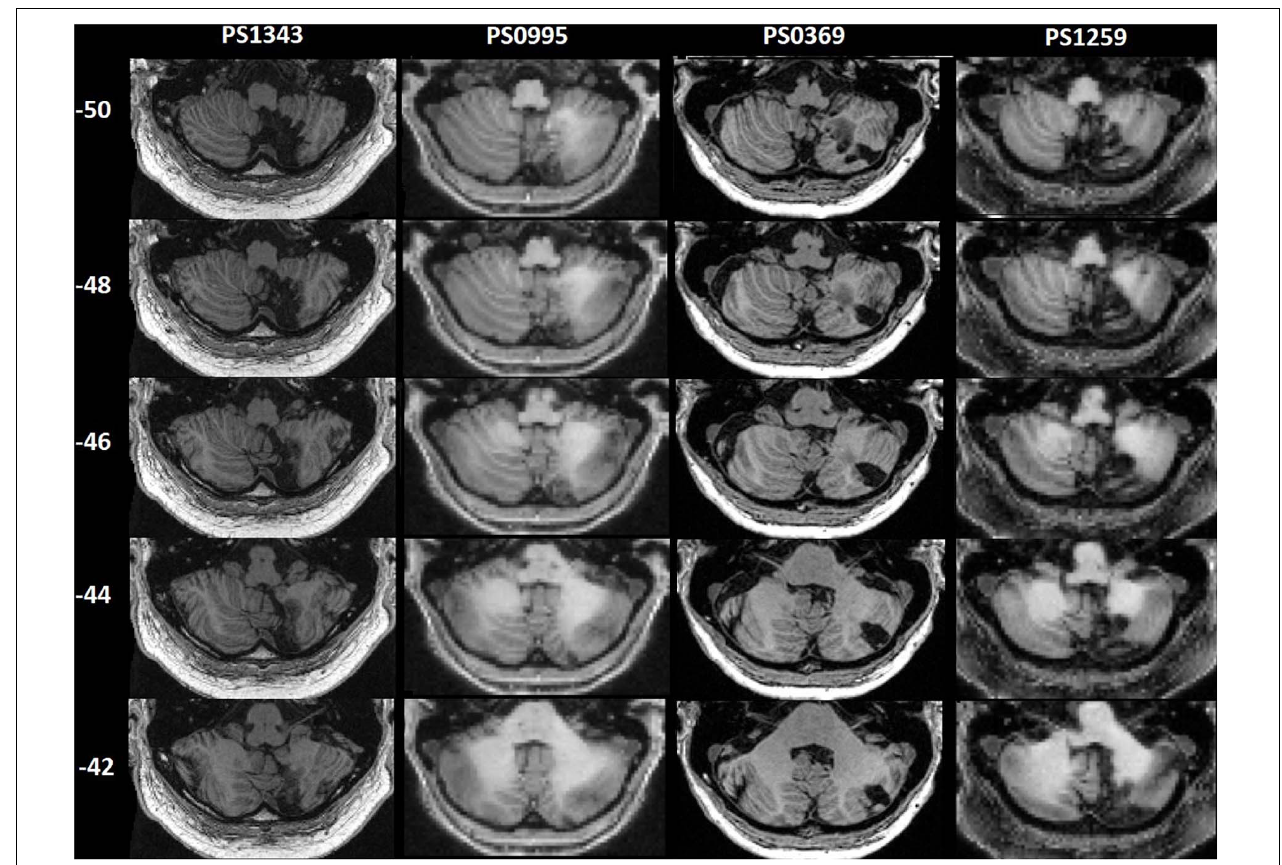
FIGURE 1 | Patients’ lesions displayed on axial slices. Patient IDs are shown above the images. z coordinates in MNI space are shown on the